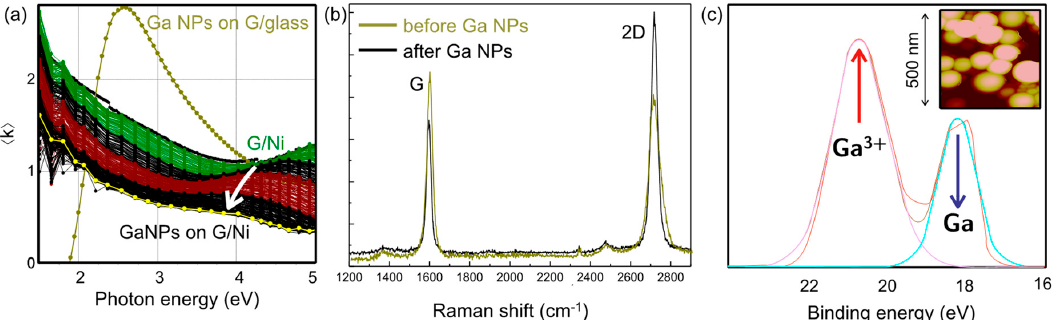
Figure 4. Ga NPs on G/Ni support. ( a ) Experimental extinction coefficient spectra 〈 𝑘 〉 recorded in 262 Figure 4. Ga NPs on G / Ni support. ( a ) Experimental extinction coe ffi cient spectra (cid:104) k (cid:105) recorded in real real time during Ga NP deposition on the G/Ni substrate. Each spectrum is acquired every 1 sec; the 263 time during Ga NP deposition on the G / Ni substrate. Each spectrum is acquired every 1 sec; the black black spectrum refers to the initial G/Ni sample; the final yellow spectrum refers to Ga NP/G/Ni; the 264 spectrum refers to the initial G / Ni sample; the final yellow spectrum refers to Ga NP / G / Ni; the arrow arrow indicates Ga NP deposition. For comparison, the 〈 𝑘 〉 spectra for equivalent Ga NPs on G/glass 265 indicates Ga NP deposition. For comparison, the (cid:104) k (cid:105) spectra for equivalent Ga NPs on G / glass is is also shown. ( b ) Raman spectra of the graphene layer before and after Ga NP deposition. ( c ) XPS 266 also shown. ( b ) Raman spectra of the graphene layer before and after Ga NP deposition. ( c ) XPS spectra of the photoelectron core level Ga3 d for Ga/G/Ni. The inset shows the AFM image of the Ga 267 spectra of the photoelectron core level Ga3 d for Ga / G / Ni. The inset shows the AFM image of the Ga NP morphology. 268 NP